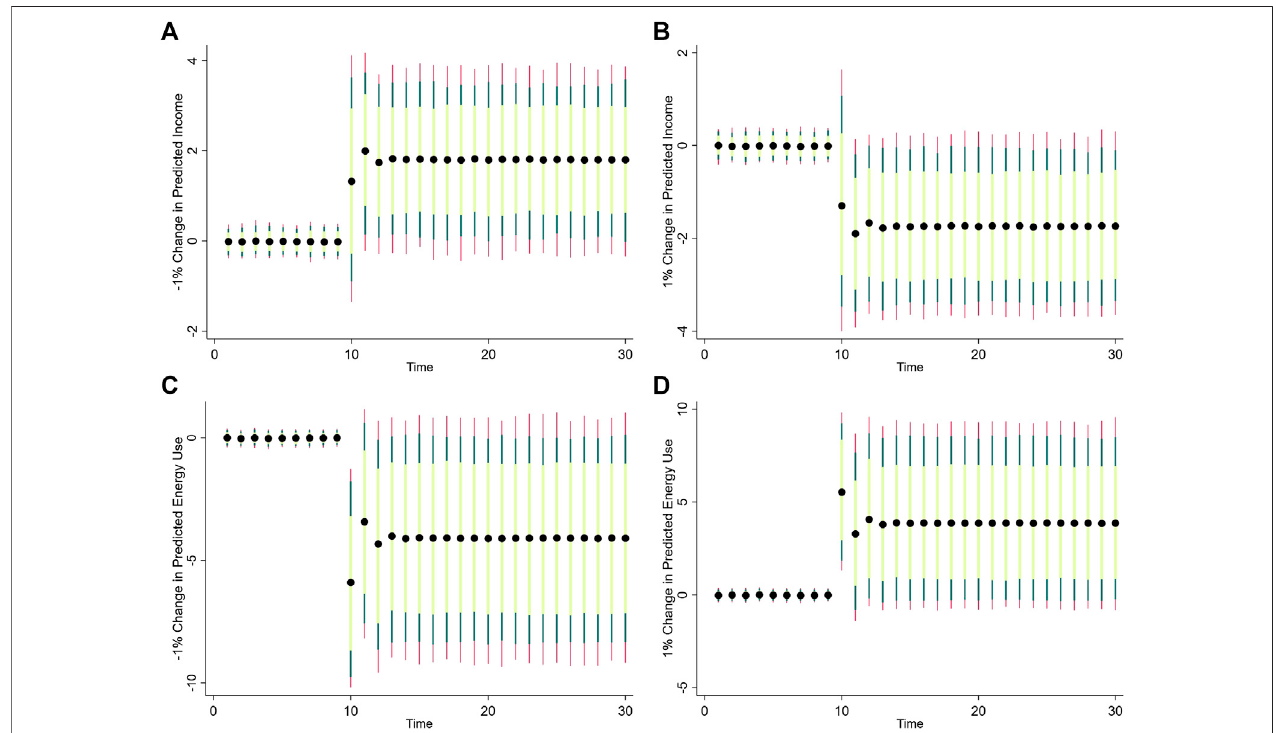
FIGURE 5 | Counterfactual shocks (A) − 1% Change in Predicted Income (B) 1% Change in Predicted Income (C) − 1% Change in Predicted Energy Use (D) 1% Change in Predicted Energy Use. Legend: The fi lled-black circle denotes the predicted shock whereas sun fl ower lime, emerald and cranberry colored spikes refer to statistical signi fi cance at 25, 10, 5%